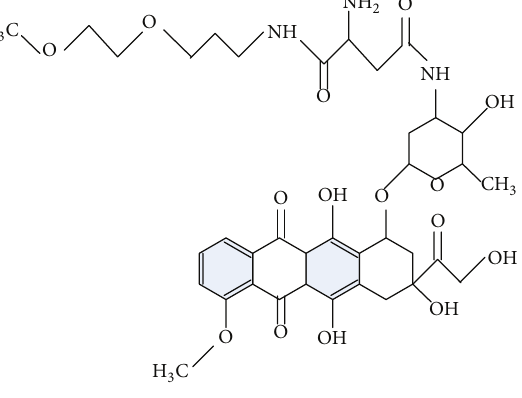
Figure 2: The molecular structure of 𝑆𝑃[1] .